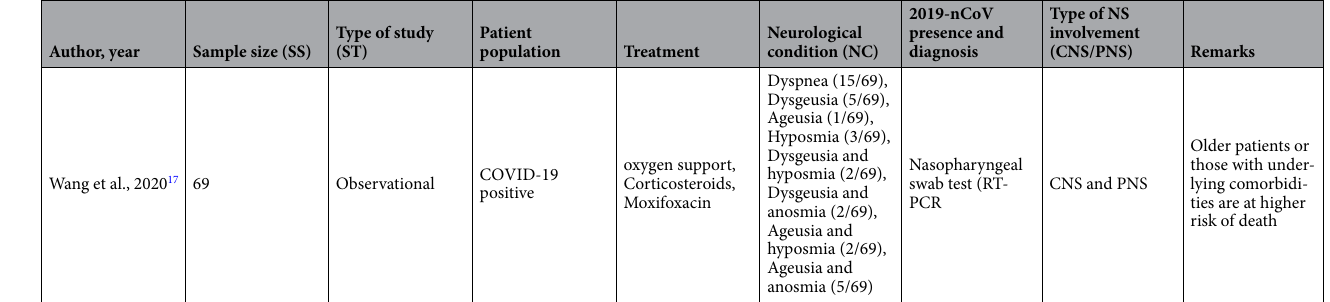
Table 1. Published observational/cross sectional studies which reported the neurological manifestation to the COVID-19 positive patients. NA not available, NS nervous system, CNS central nervous system,